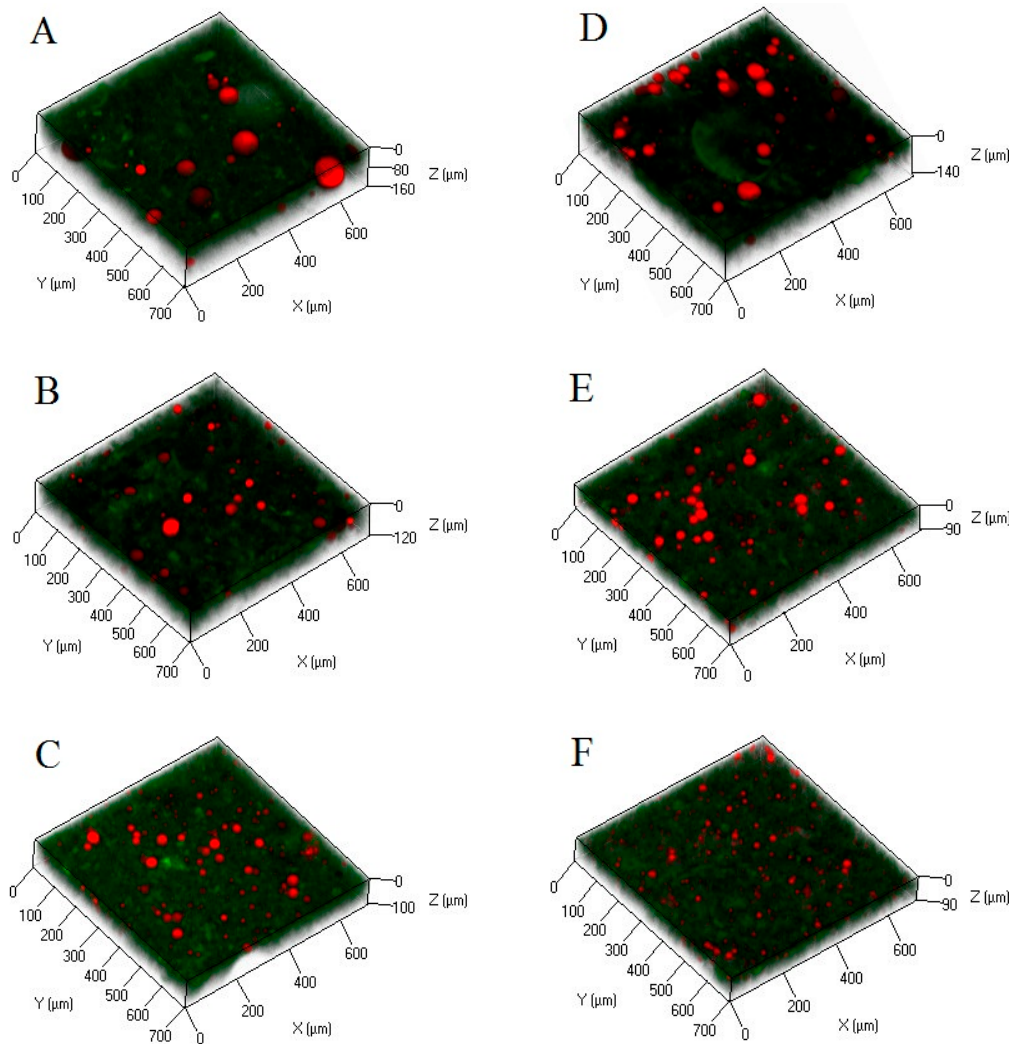
Figure 1. Microstructure of gels containing MP- or Tween 80-stabilized camellia seed oil emulsions. ( A – C ) = MP-stabilized emulsions homogenized at a speed of 5000 rpm, 10,000 rpm, and 15,000 rpm, respectively; ( D – F ) = Tween 80-stabilized emulsions homogenized at a speed of 5000 rpm, 10,000 rpm and 15,000 rpm, respectively. Fats are shown in red, and proteins are shown in green.